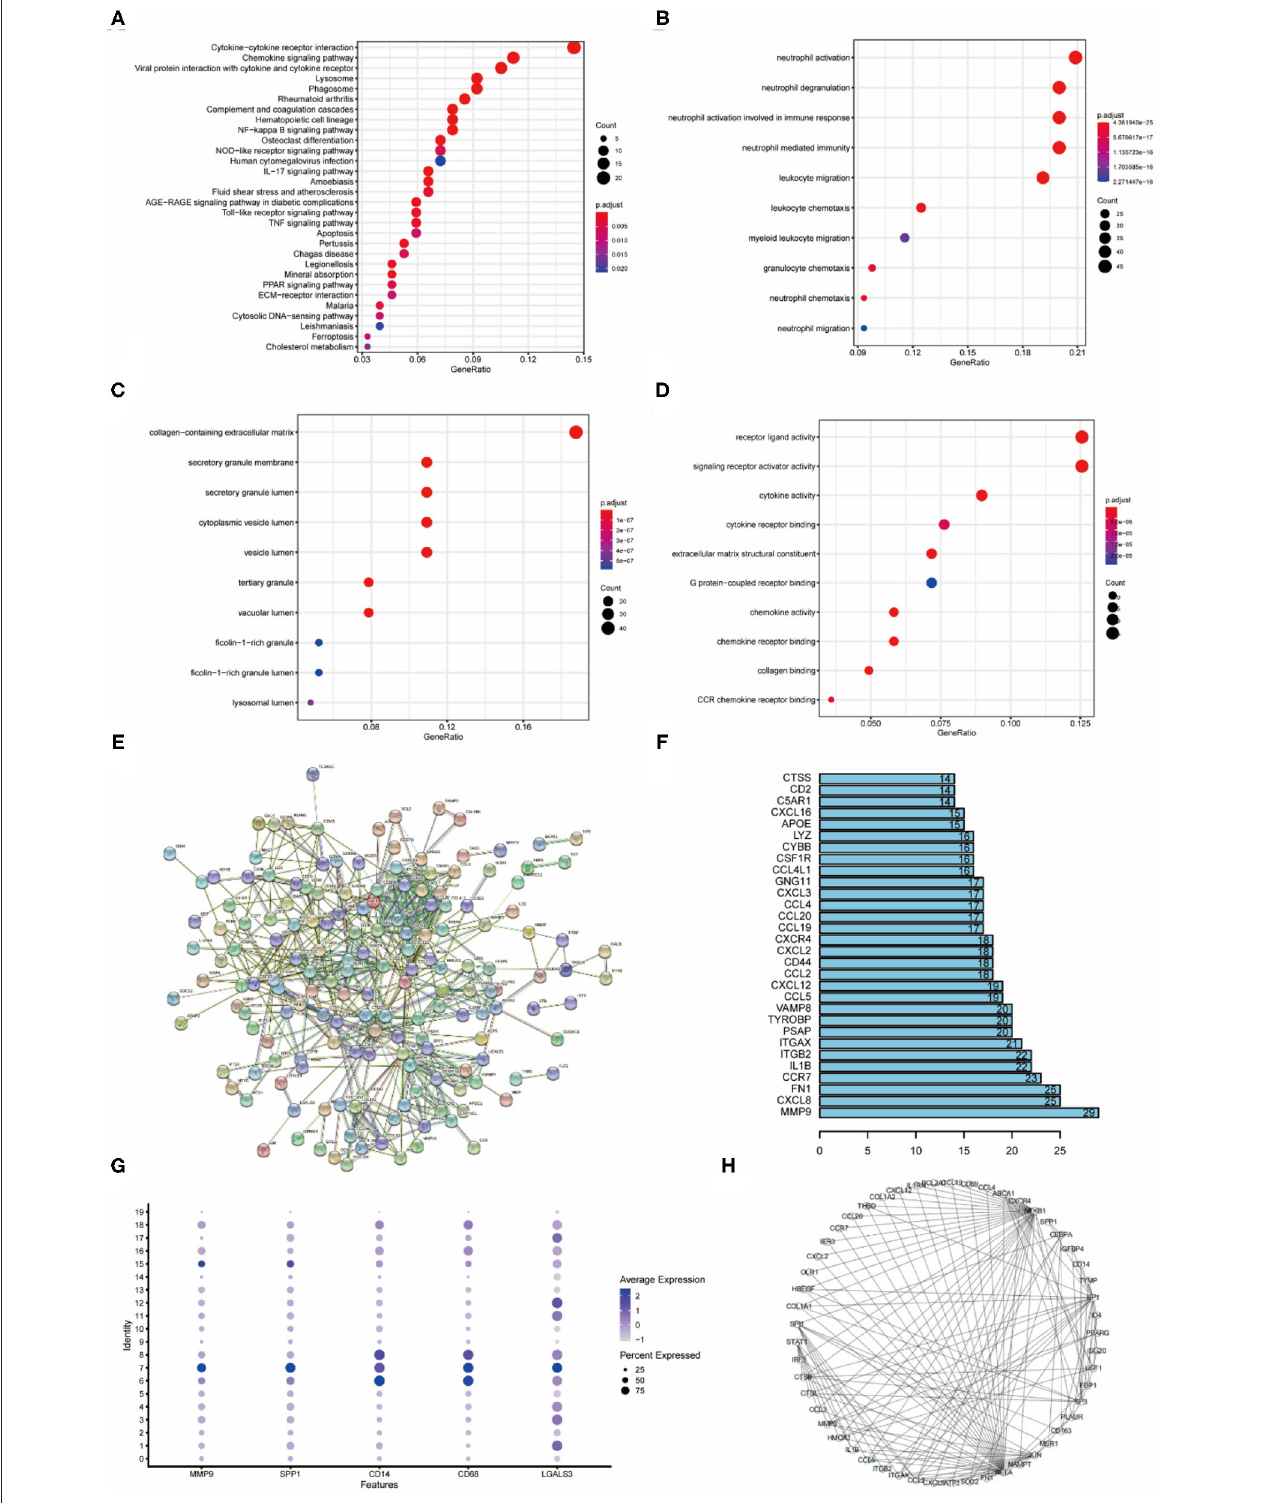
FIGURE 3 | Enrichment analysis of cluster7, protein interactions, upstream transcription factors (A) KEGG enrichment analysis of cluster 7. (B) Biological process enrichment analysis of cluster 7. (C) Enrichment analysis of cellular component of cluster 7. (D) Enrichment analysis of molecular function of cluster 7. (E) Protein interaction network of cluster 7 differential genes. (F) Statistics of cluster 7 protein-interaction pairs. (G) Specific expression of cluster 7 genes. (H) Upstream transcription factor relationship map of cluster 7 differential genes.